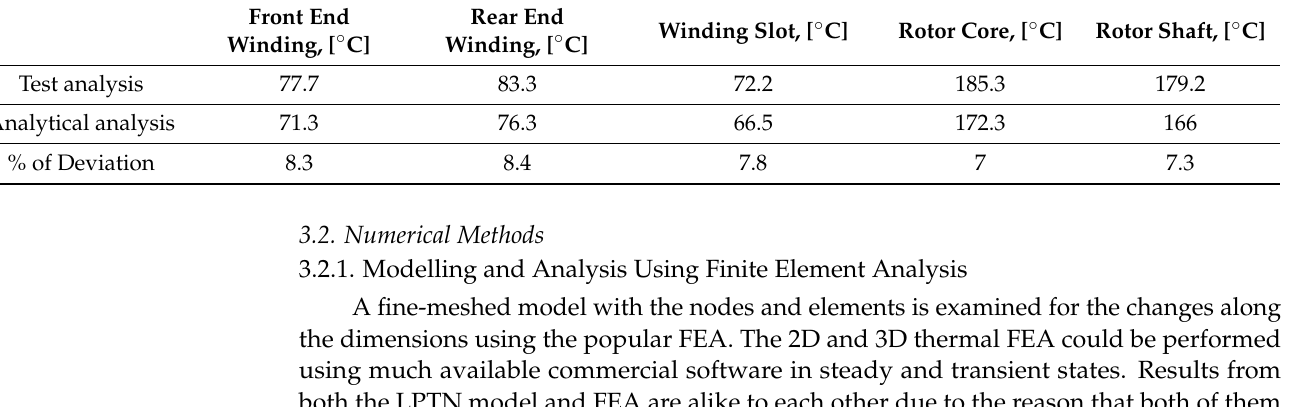
Table 1. Temperature distribution by thermal analysis [19].